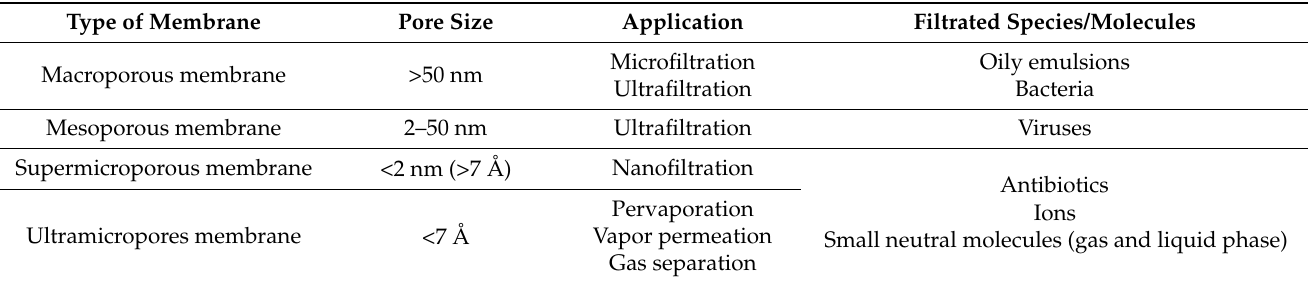
Abbreviations used in Table 1: nm—nanometer;